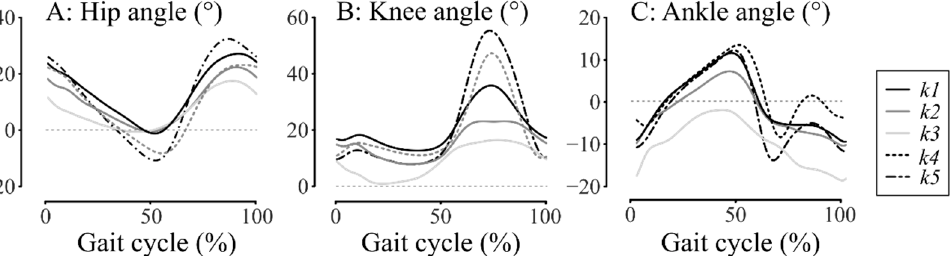
Figure 3. Mean sagittal kinematics of: ( A ) hip joint, ( B ) knee joint, and ( C ) ankle joint. k1 is the black line, k2 is the mild grey line, k3 is the light grey line, k4 is the black dashed line, and k5 is the dash-dotted black line. Table 4. Clustering results, clinical and gait characteristics (median and [1st–3rd quartiles]), and sagittal kinematic parameters (mean ± SD) for the different clusters ( k1 to k5 ) and results of the one- way ANOVA or Kruskal–Wallis tests.